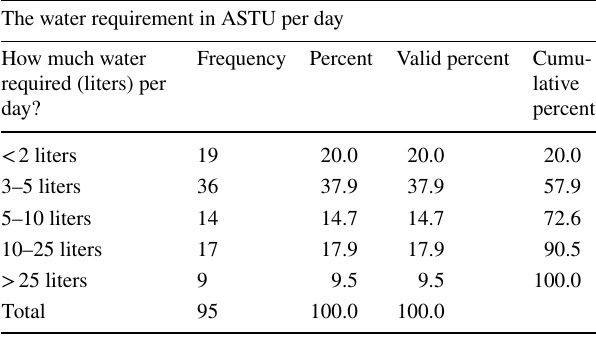
Fig. 5 The availability of suf- ficient water by respondents’ response in